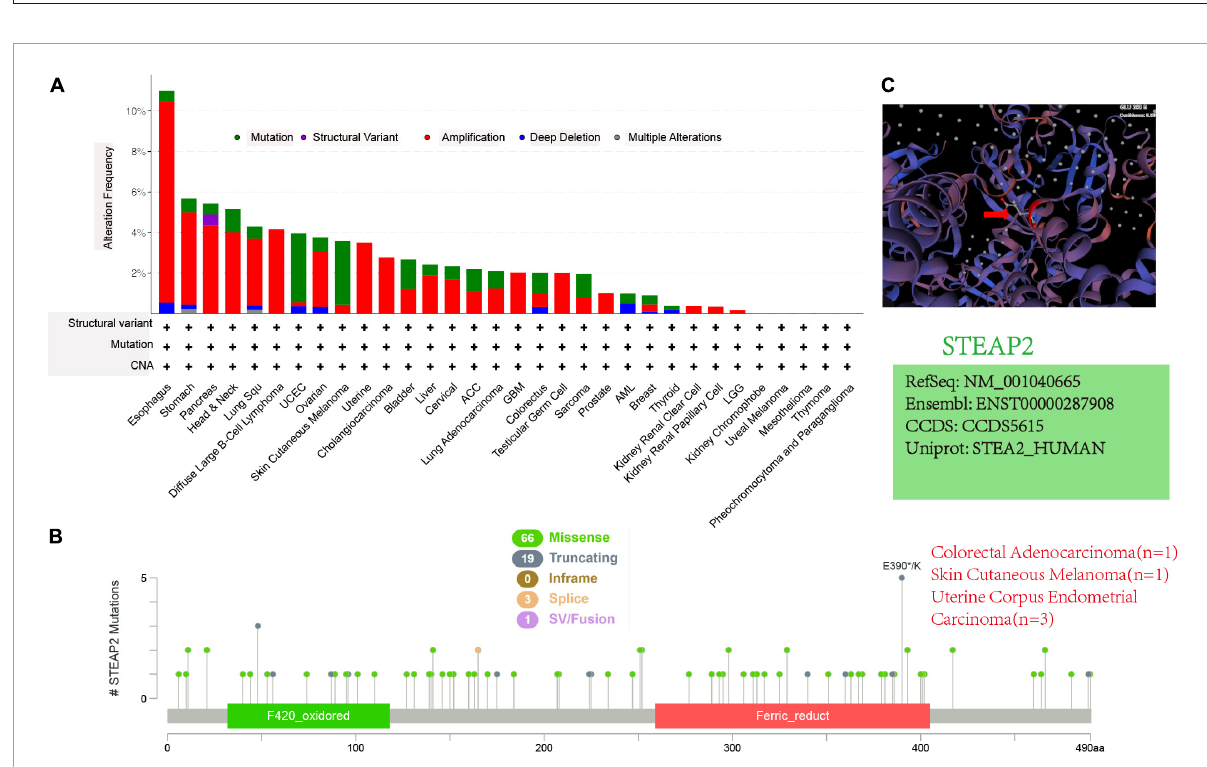
FIGURE6 Mutation features of STEAP2 in different tumors of TCGA. (A,B) Alteration frequency with mutation type and mutation site. (C) Mutation site with the highest alteration frequency (E390) in the 3D structure of STEAP2.